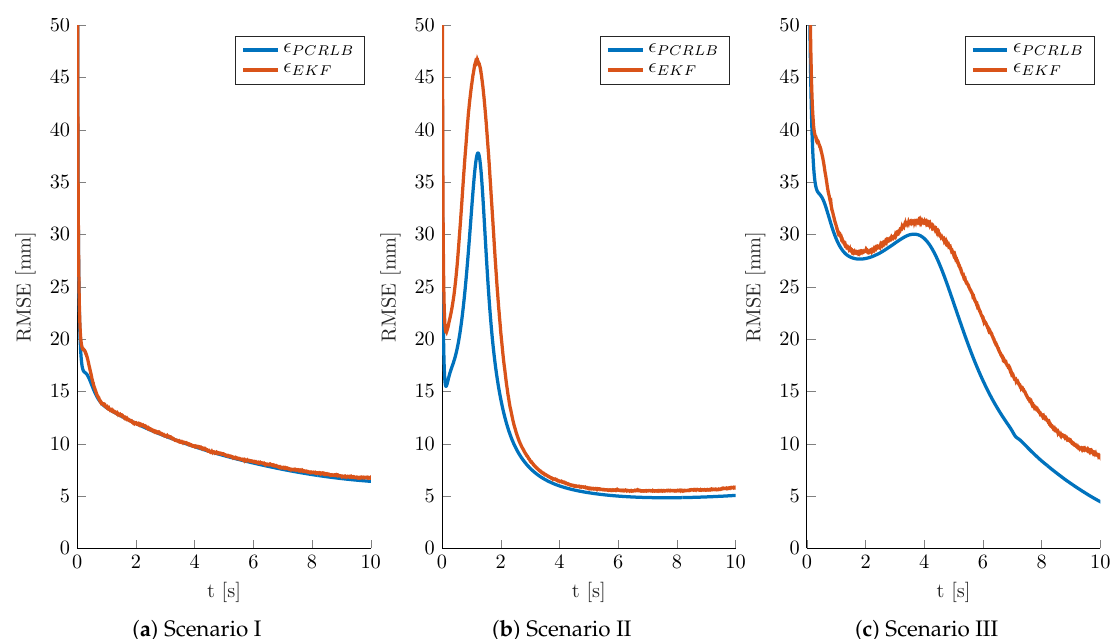
Figure 3. Simulation results for Scenarios I–III as provided in Figure 2b. Results for both PCRLB and EKF are given in terms of RMSE, referred to as (cid:101) PCRLB and (cid:101) EKF